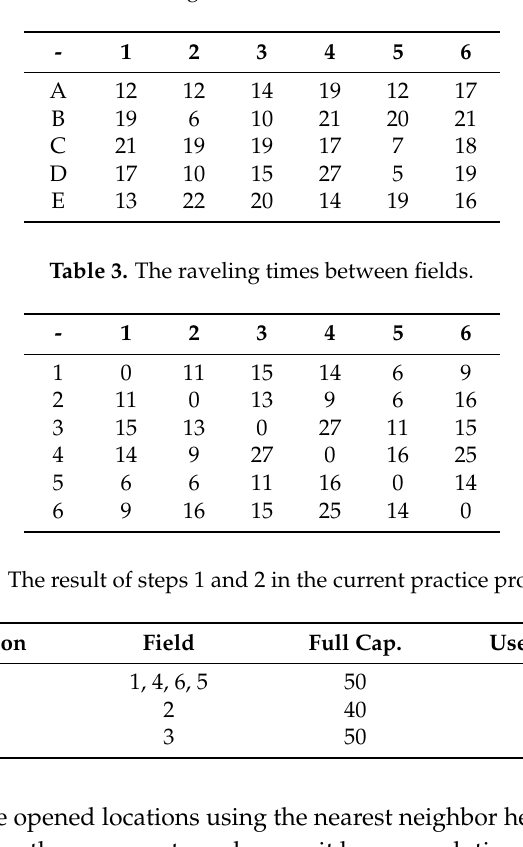
Table 2. The traveling times of the locations to the fields.